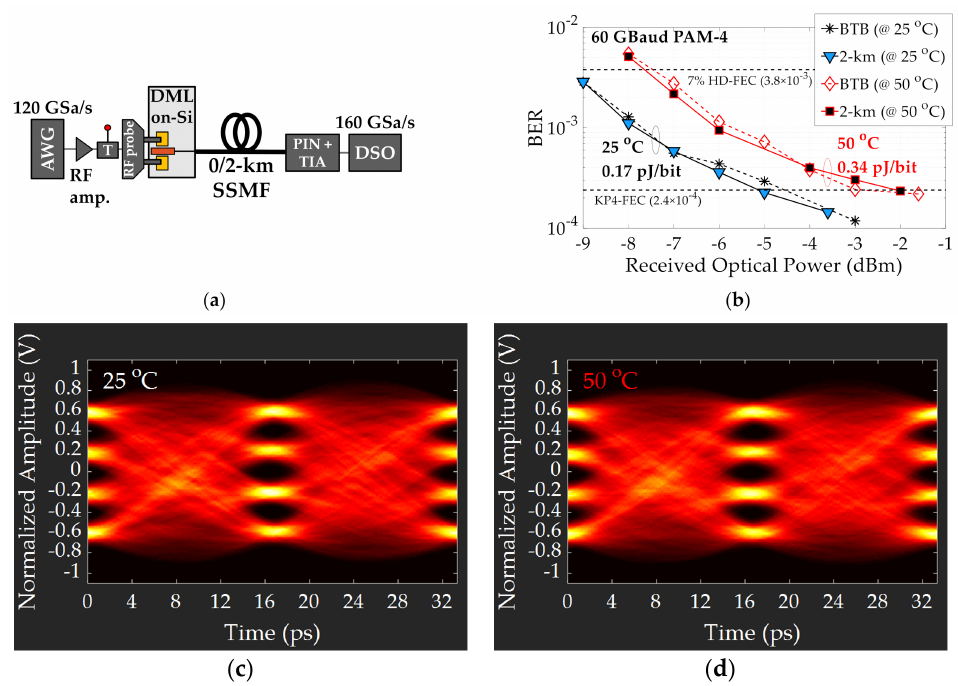
Figure 5. 60 GBaud PAM-4 signal evaluation: ( a ) Experimental setup; ( b ) Bit-error rate (BER) versus received optical power at back-to-back (BTB) and after 2-km SSMF transmissions, and ( c , d ) Eye diagrams after equalization. Measurements were performed at 25 ◦ C ( I b = 9.1 mA) and 50 ◦